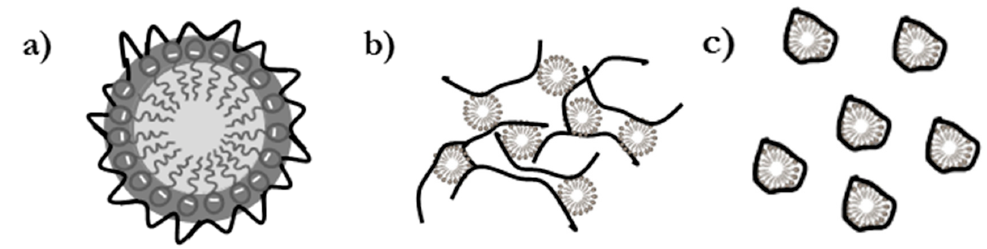
Figure 2. ( a ) Scheme representing the model assumed for Self-Consistent Mean-Field Calculations (SCF) calculations. ( b ) Scenario for those systems in which micelles bridge several polymer chains (formation of multichain complexes, g PS > 1). ( c ) Scenario for those systems in which micelles do not bridge polymer chains ( g PS < 1).